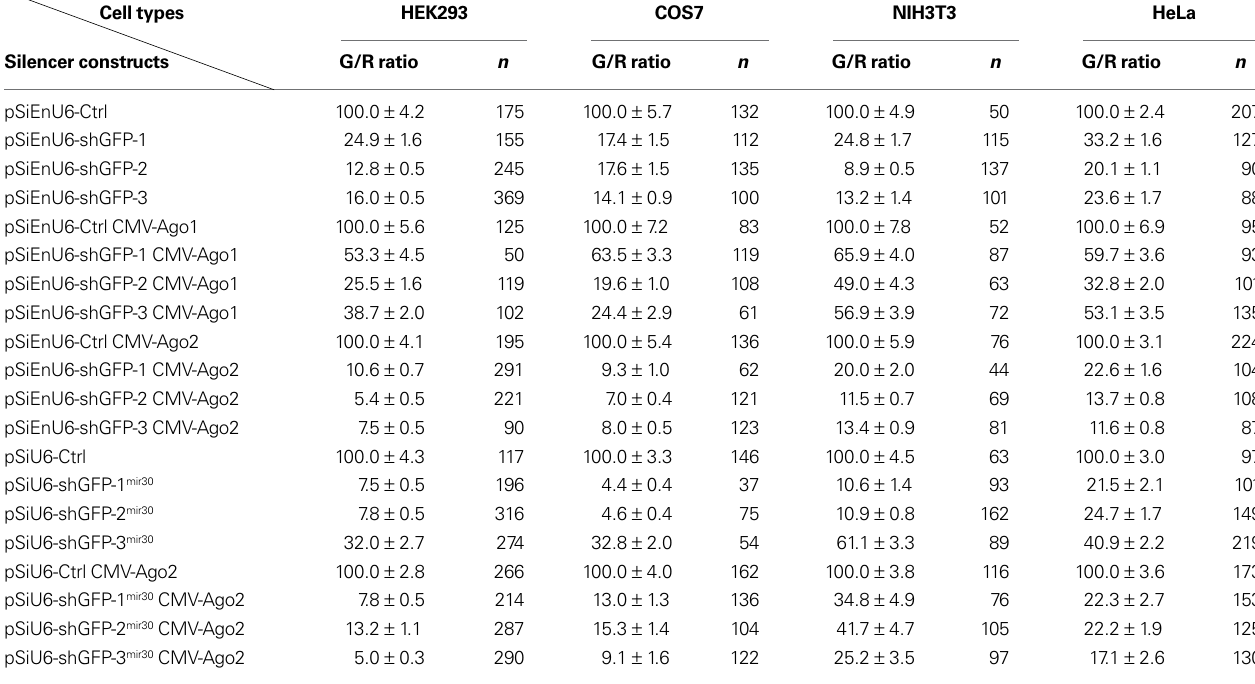
Table 2 | Effect of RNAi with different silencer constructs containing different promoters or structures of shRNAs in different cell